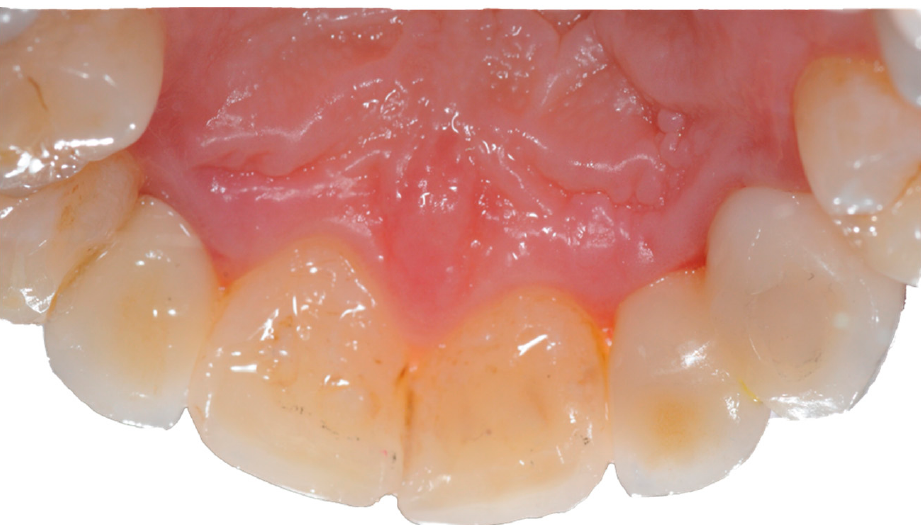
Figure 3. After screwing the restoration (tooth number 1.2 and 1.3) to the implant fixture the access hole, moved to the palatal surface, was sealed.